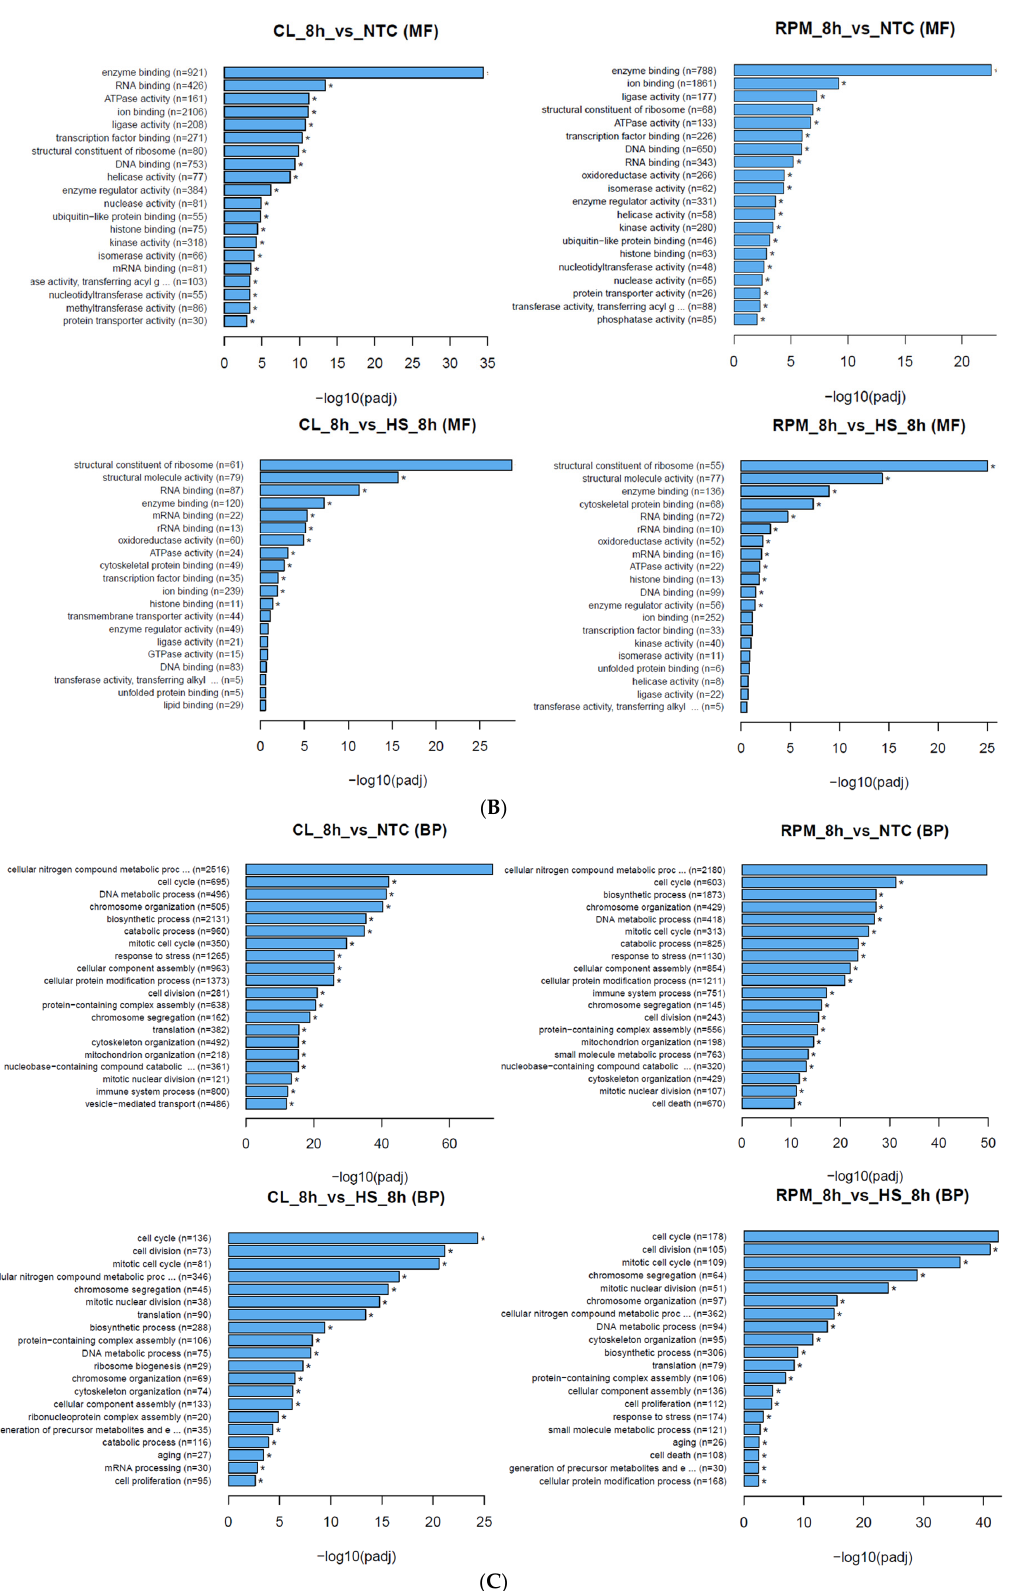
Figure A2. Gene Ontology (GO) enrichment analysis. Treatment versus control comparison for: ( A ) Cellular component (CC), ( B ) molecular function (MF), and ( C ) biological processes (BP) terms. * denotes significantly enriched GO terms. Top 20 significantly enriched GO terms are